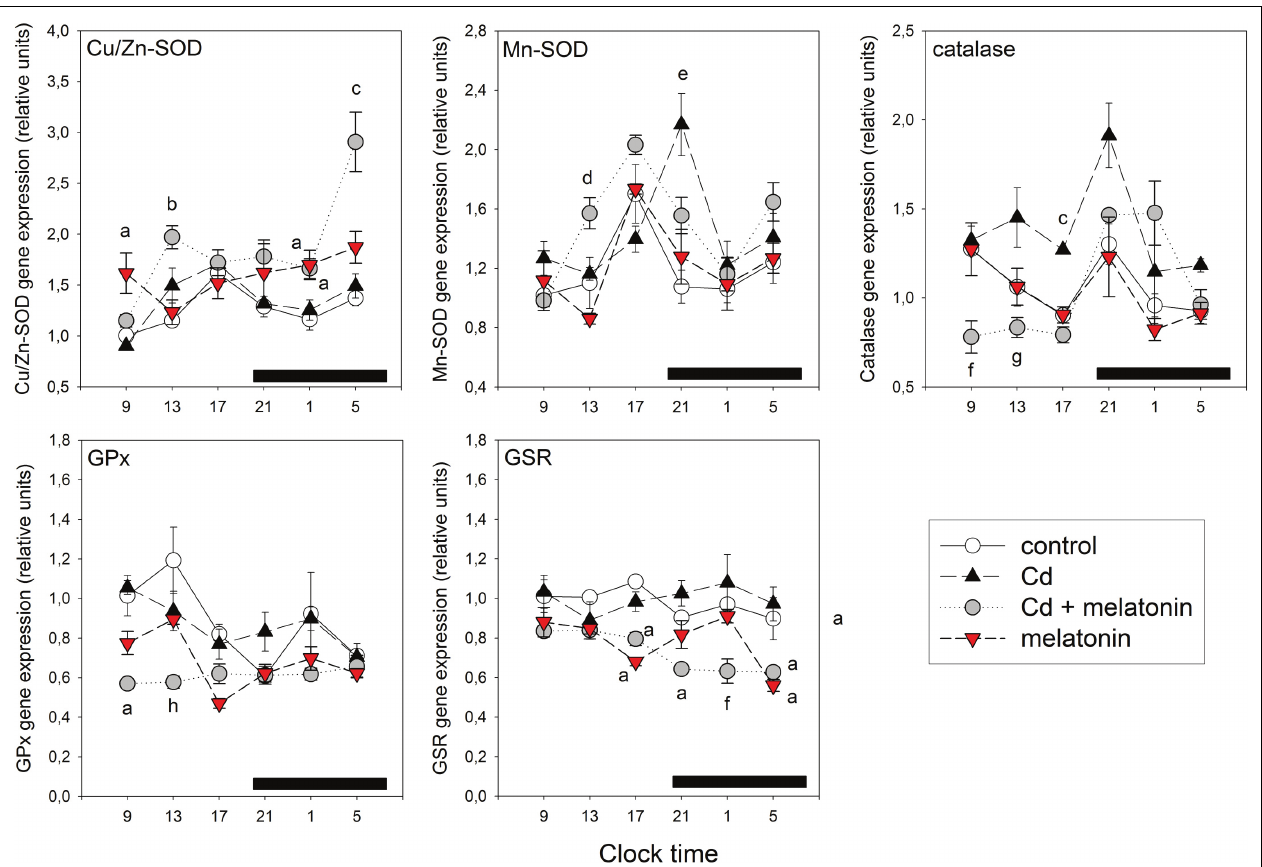
FIGURE 2 | Effect of melatonin on Cd-induced changes in 24-h pattern in expression of mRNA for Cu/Zn-SOD, Mn-SOD, catalase, Gpx, and GSR in rat MBH. For experimental details see legend to Figure 1 . mRNA levels encoding the enzymes were measured as described in the text. Shown are the mean ± SEM of mRNA determination as measured by triplicate real-time PCR analyses of RNA samples. Letters denote significant differences in a one-way ANOVA followed by a Bonferroni’s multiple comparison test performed at every time interval, as follows: a p < 0.02 vs. Cd and control groups; b p < 0.05 vs. melatonin and control groups; c p < 0.01 vs. the remaining groups; d p < 0.05 vs. melatonin and Cd groups; e p < 0.05 vs. melatonin and control groups; f p < 0.05 vs. the remaining groups; g p < 0.01